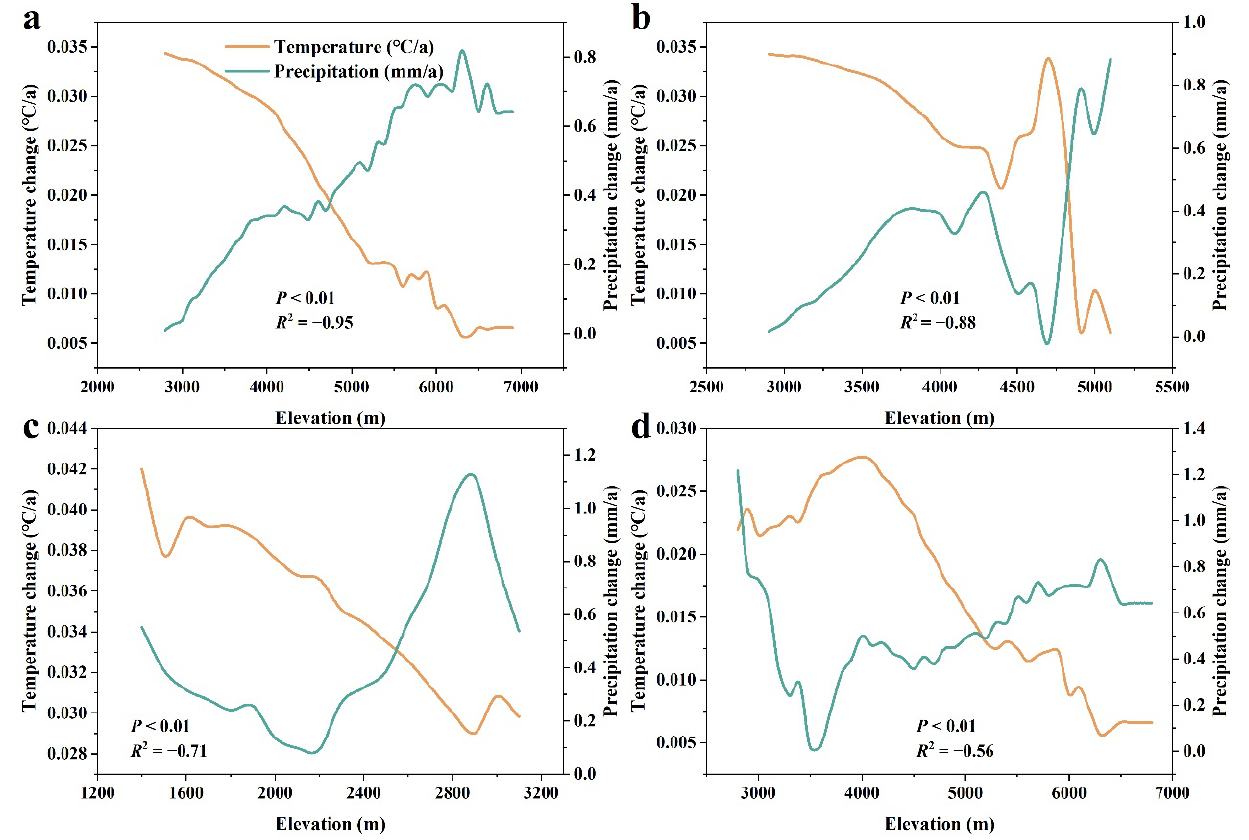
Figure 5. Climate trends at different altitudes in the warming and wetting areas of the Tianshan Mountains Ecozone. ( a ): all vegetation zones above 2800 m. ( b ): Alpine meadow. ( c ): coniferous forests. ( d ): nival belt.